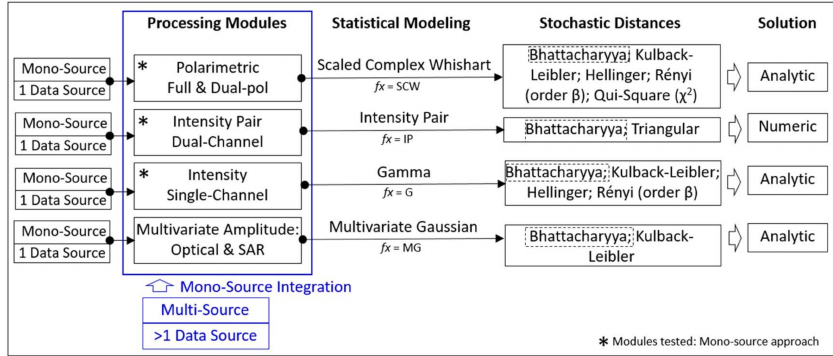
Figure 1. The Multi-Source image processing architecture indicating the four module